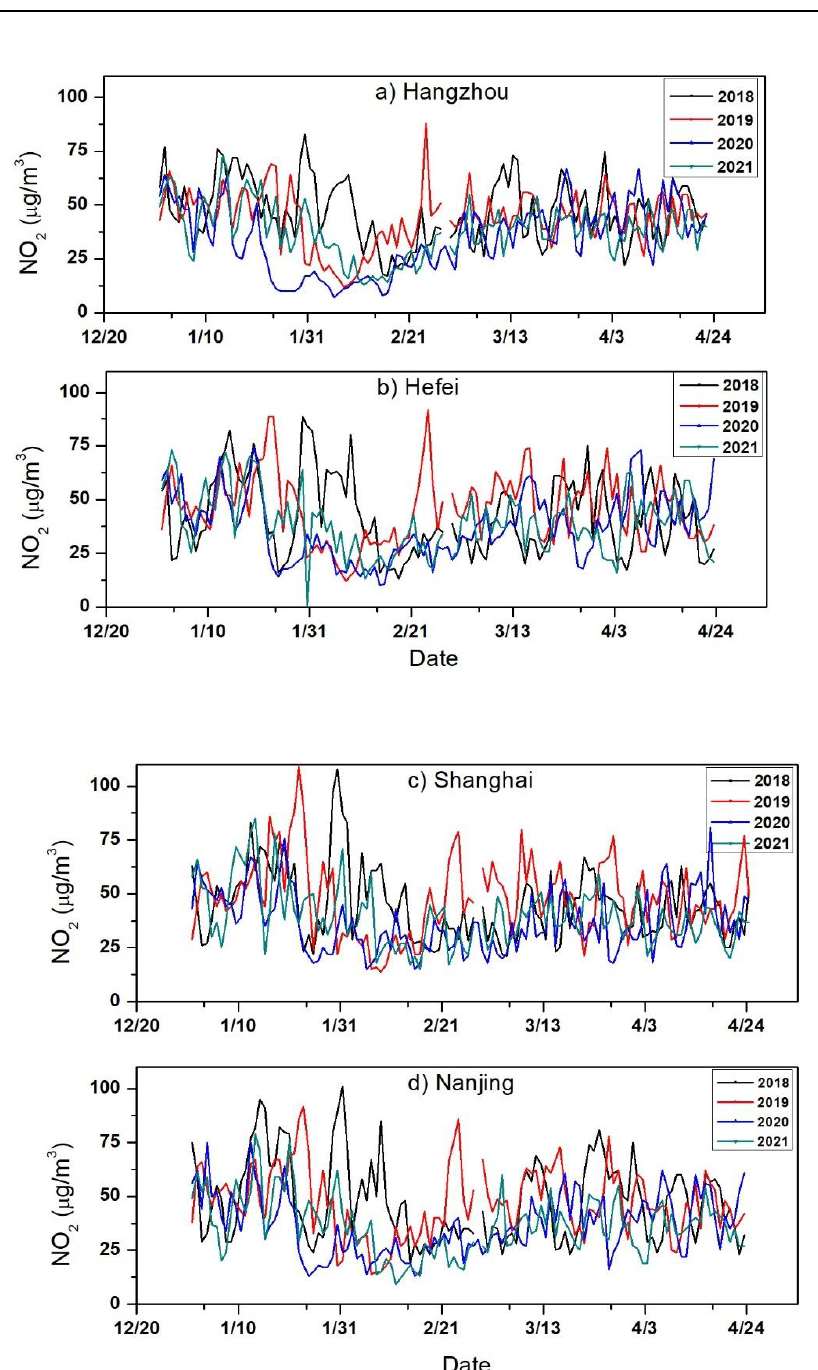
Figure 2. Time series of daily averaged NO 2 over major cities of the YRD region. Table 2 shows percentage change in NO 2 over different cities for Level-1 and Level-2 compared to the pre-lockdown days from 2018 to 2021 where negative sign indicates re- duction while positive shows increase in concentration. It is evident that the concentration of NO 2 is considerably lower during Level 1 of the lockdown during 2020 as compared to other years. This phenomenon is observed in all the cities which correspond to signifi- cantly reduced anthropogenic activity during lockdown Level 1. Table 2. Percentage change in mean NO 2 during lockdown levels (Level-1 (24 January–26 February) and Level-2 (27 February–31 March)) with reference to Pre-lockdown Phase (1 January–23 January).